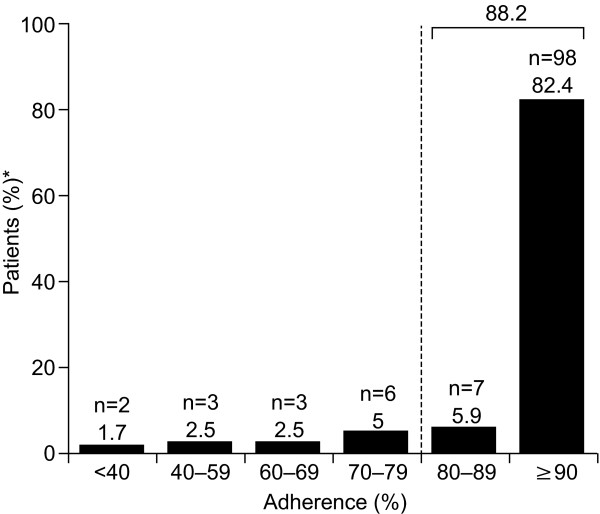
Patient adherence at Week 12 in the intent-to-treat population (n = 119). *Percentages may not add up to 100 due to rounding.